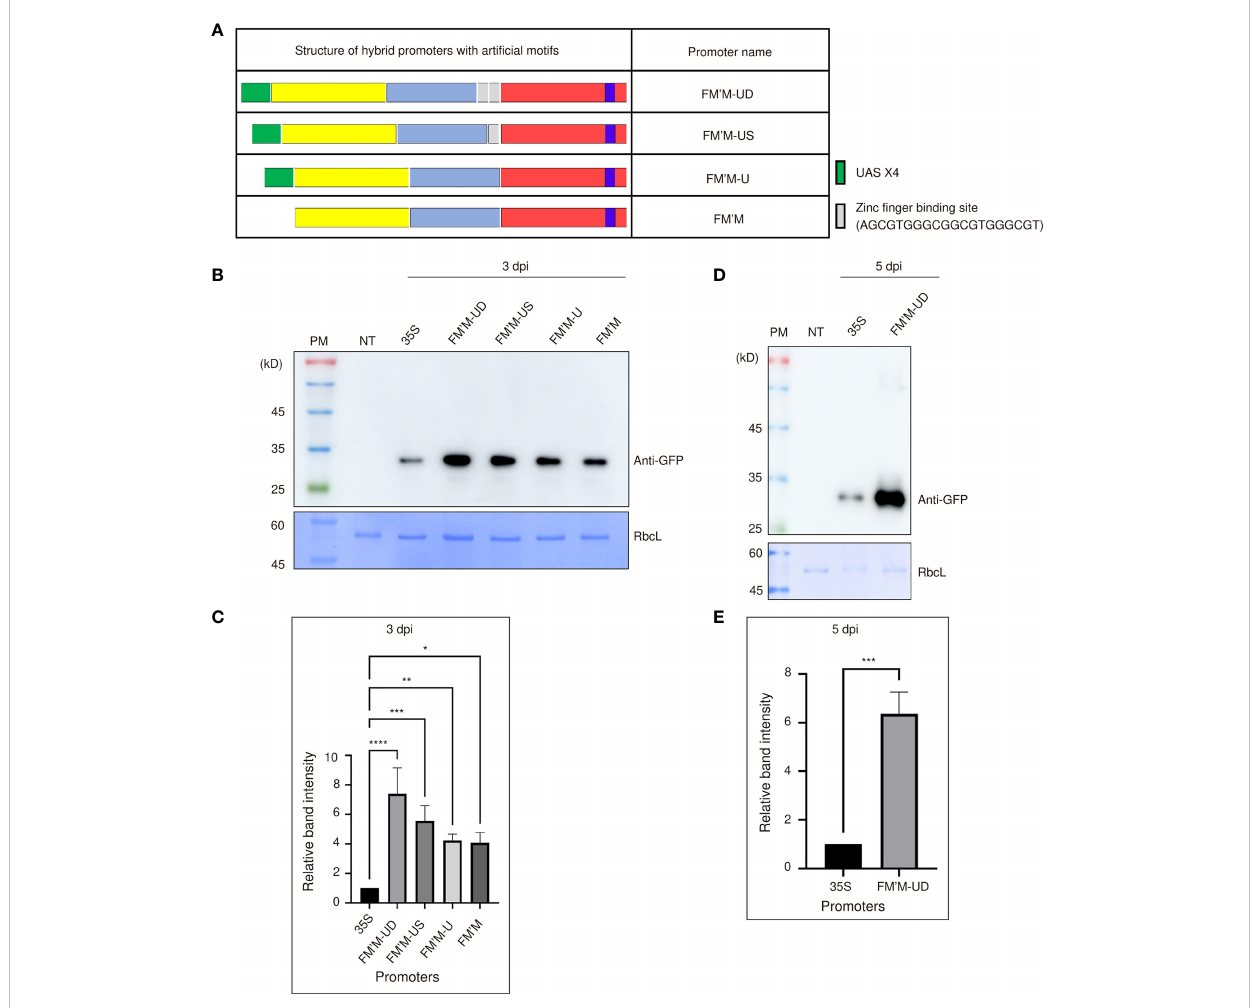
FIGURE 2 Insertion of UAS×4 and zinc fi nger binding sites enhances the strength of the FM ′ M promoter. (A) Schematic presentation of the hybrid promoter containing UAS×4 and zinc fi nger motifs. The sequence of the zinc fi nger motif is shown. (B-E) Expression level analysis of promoters. Reporter constructs consisting of the indicated promoters and GFP were transiently expressed in tobacco ( N. benthamiana ) leaves via Agrobacterium - mediated in fi ltration. (B, D) Total protein extracts (500 ng of total protein) were prepared from leaf tissues at 3 (B) or 5 (D) dpi and analyzed by western blotting using anti-GFP antibody. Identical membranes were stained with CBB; RbcL was used as a loading control. (C, E) To quantify the expression levels of GFP at 3 (C) and 5 (E) dpi, the GFP band intensities in the images shown in (B, D) were measured using the LAS-3000 imaging system; values shown are relative to that produced by the CaMV 35S promoter. Data shown are means ± SE (n = 3). Data were analyzed by one-way ANOVA followed by Dunnett ’ s multiple comparison test; asterisks indicate statistically signi fi cant differences; *: P < 0.05; **: P < 0.01; ***: P < 0.001; ****: P <